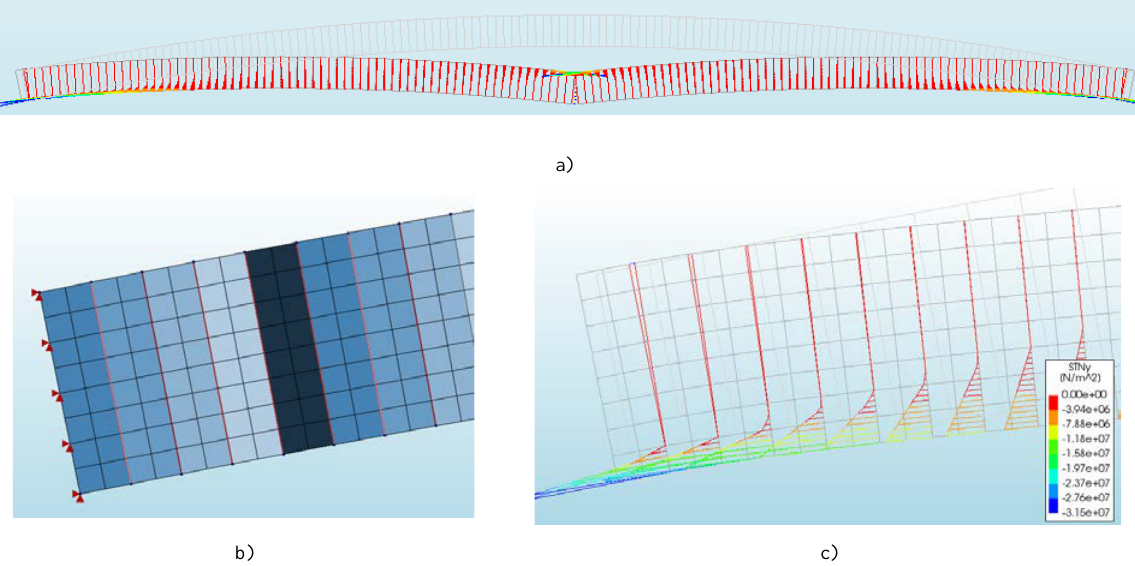
Fig. 8 Fig.s of the 2D finite element model, a) global view with deformation just before snap-through; b) supports at end of arch; c) support section view with stresses in interfaces just before snap-through.